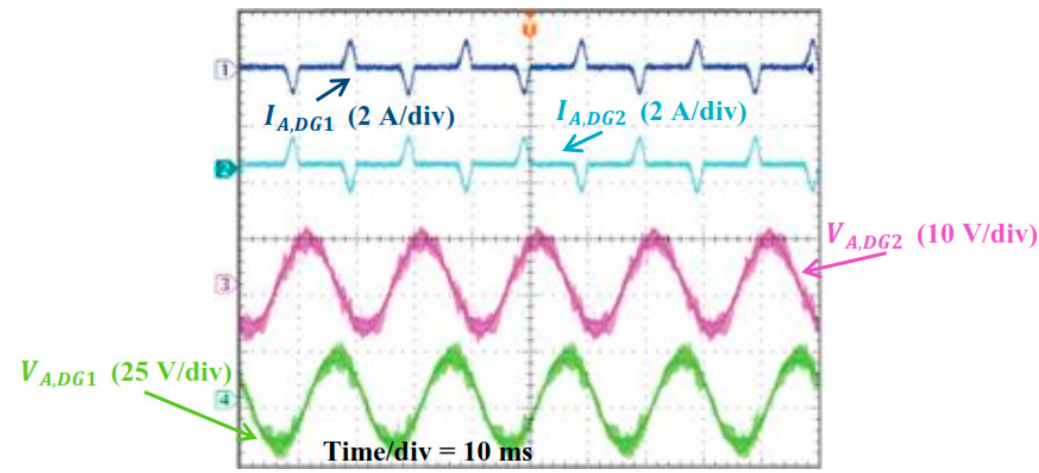
Figure 10. Experimental results of proposed controller for nonlinear load: ( dark blue trace ) DG 1 output current, ( light blue trace ) DG 2 output current, ( green trace ) DG 1 output voltage, ( pink trace ) DG 2 output voltage.